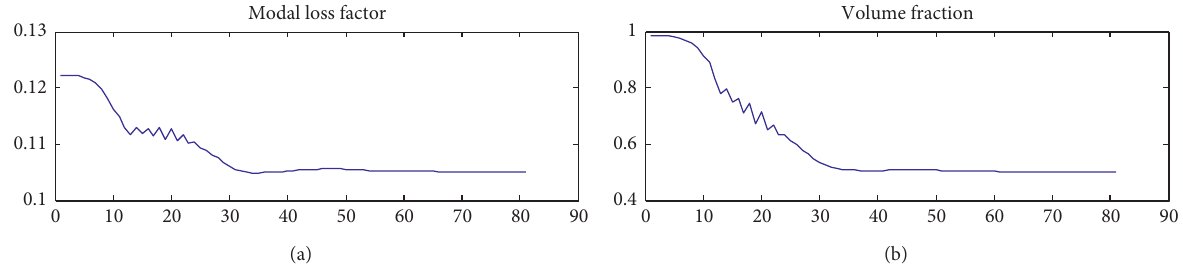
Figure 13: Convergence curves of the modal loss factor (a) and volume fraction (b) of the damping layer for the 5th modal with one hole as the initial design ( τ � 0 . 5).